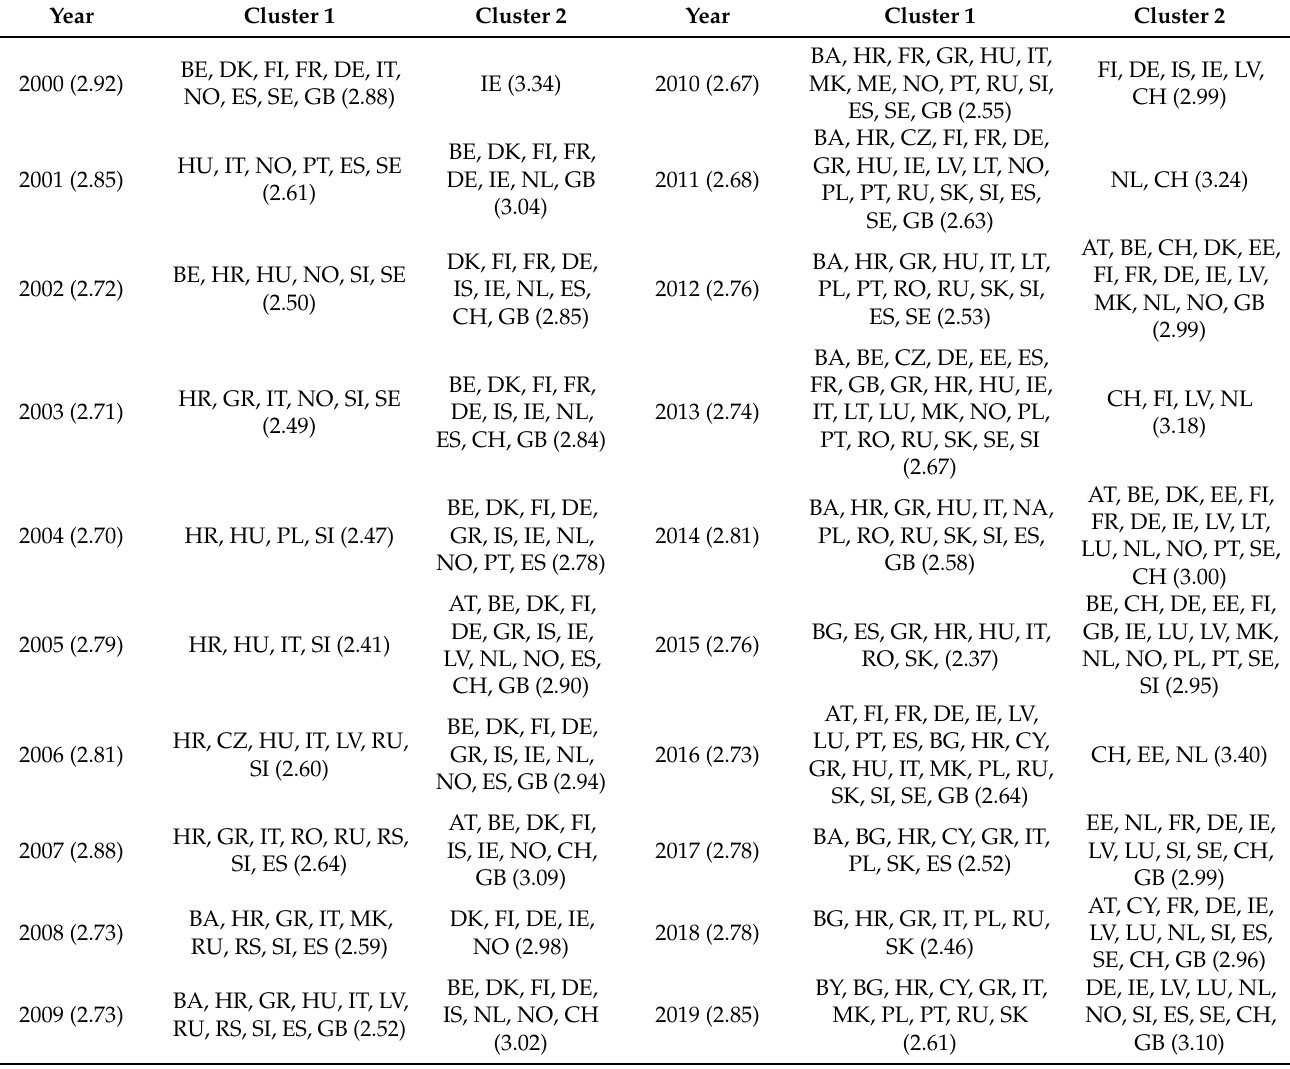
Table 2. Clusters of European Economies from 2000 until